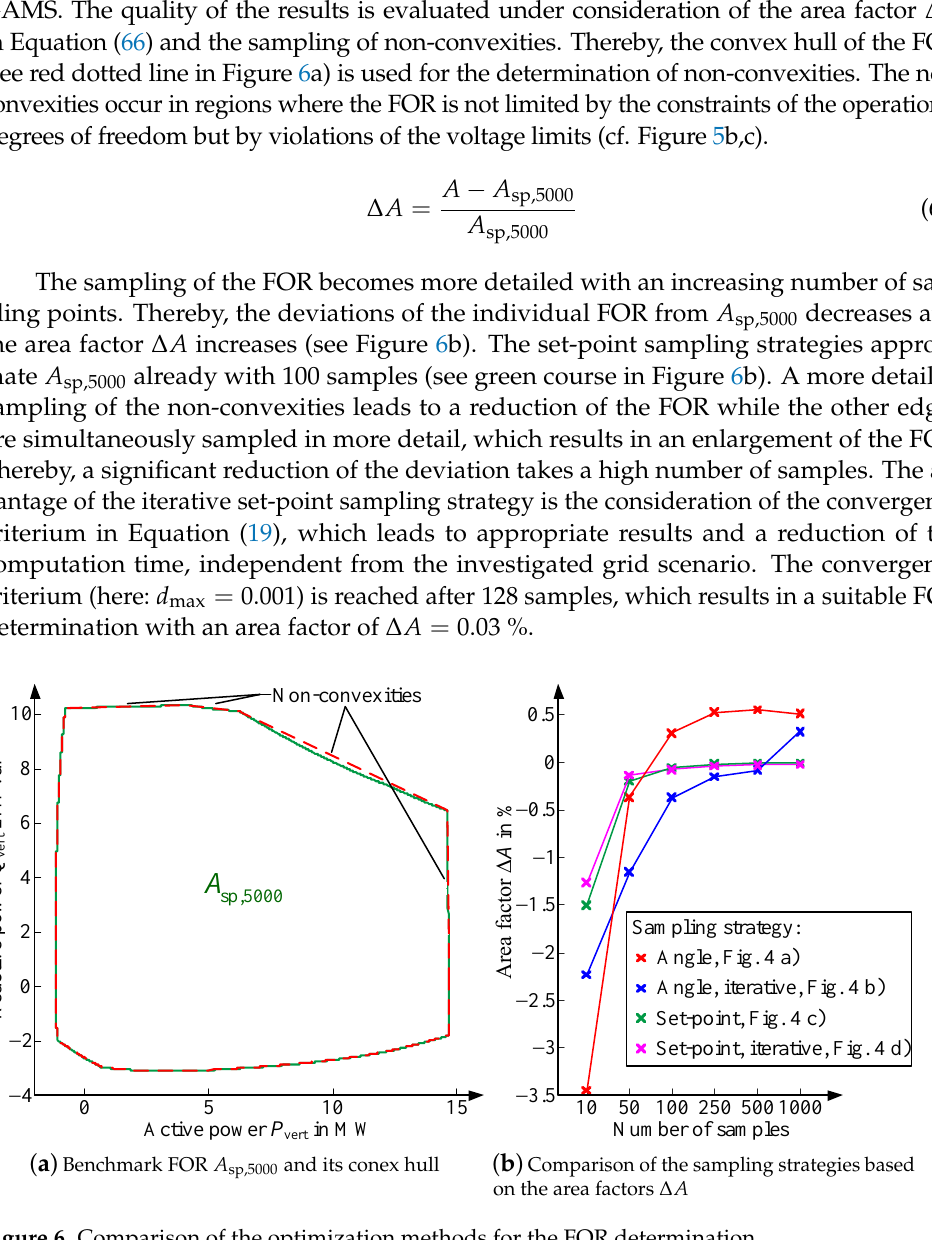
Figure 6. Comparison of the optimization methods for the FOR